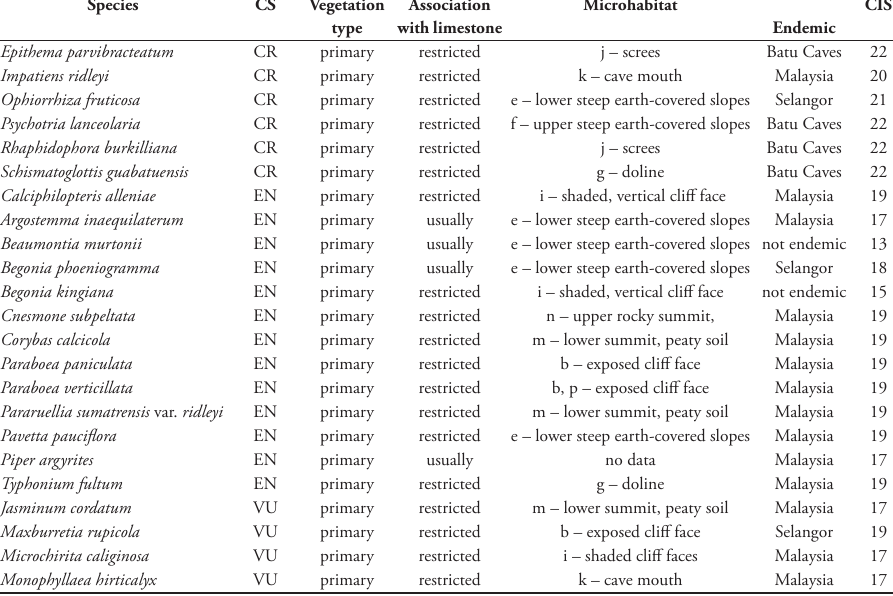
Association Microhabitat CIS type with limestone Endemic